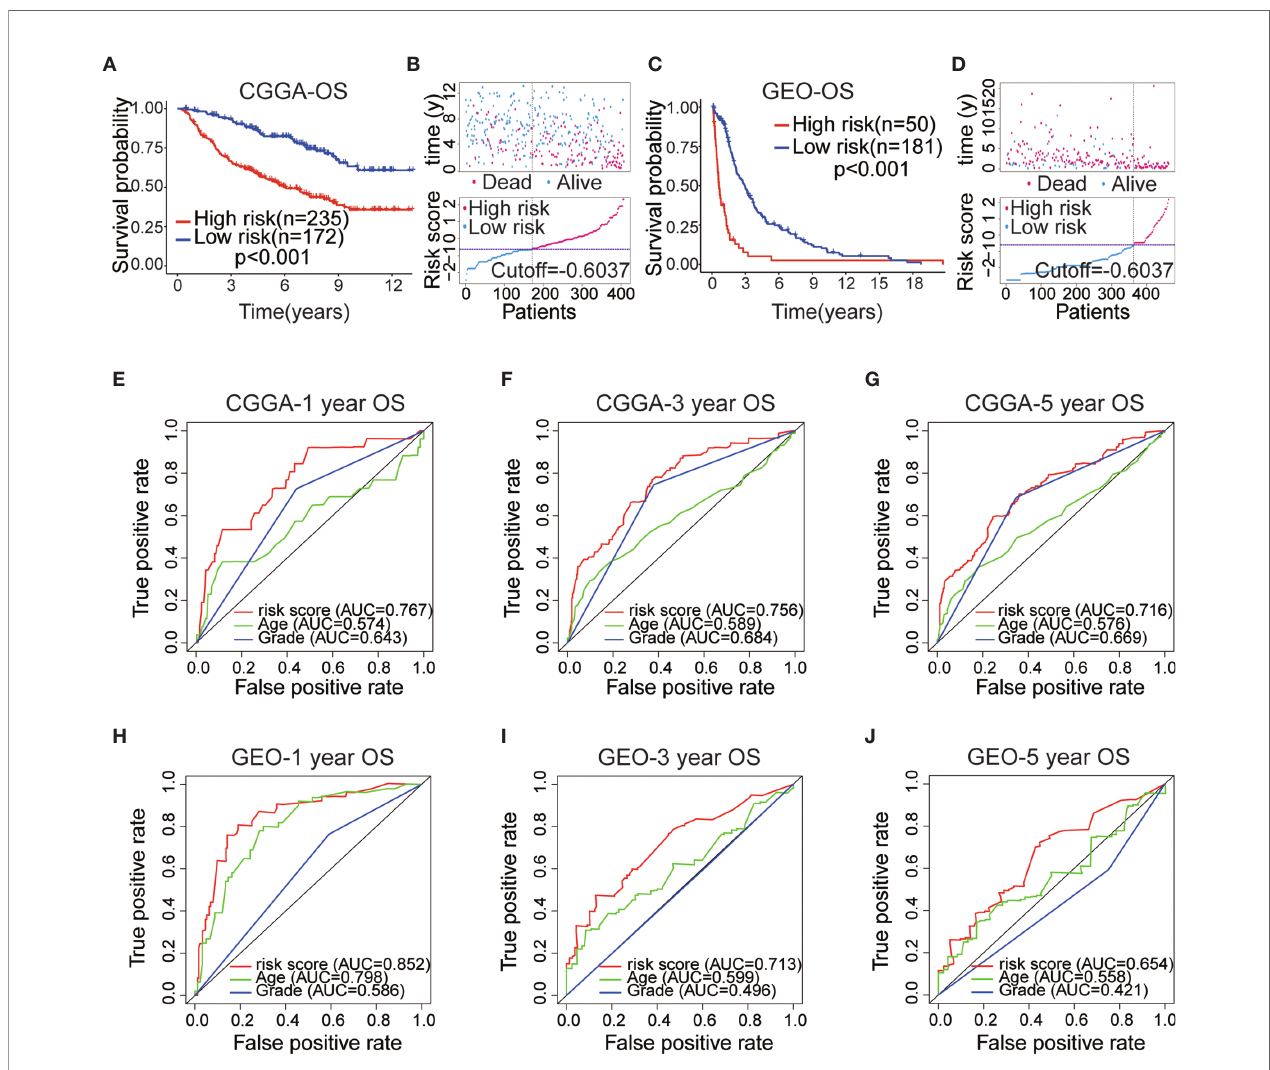
FIGURE 3 | (A) Kaplan – Meier (KM) survival curves of 10 immune-related gene pairs (IRGPs) in the China Glioma Genome Atlas (CGGA) validation dataset. (B) Survival status and risk score distribution scatter plots of primary low-grade glioma (LGG) patients in the CCGA dataset. (C) KM survival curves of 10 IRGPs in the Gene Expression Omnibus (GEO) validation dataset. (D) Survival status and risk score distribution scatter plots of primary LGG patients in the GEO dataset. (E – G) ROC curves of the IRGP signature for predicting 1/3/5-year survival in the CGGA dataset. (H – J) ROC curves of the IRGP signature for predicting 1/3/5-year survival in the GEO